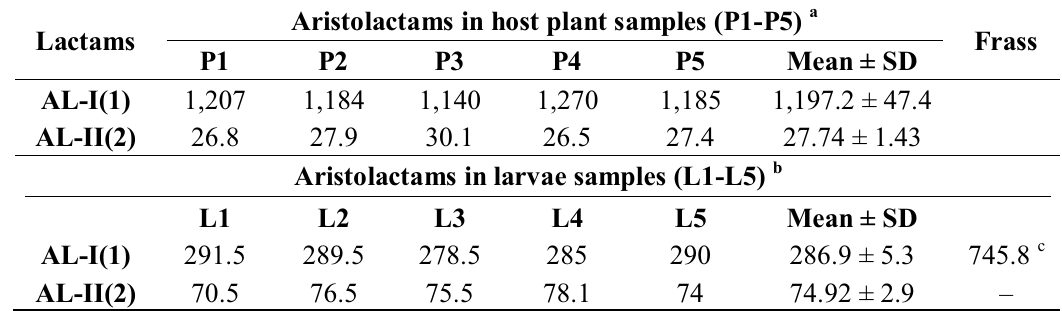
Table 2. Amount of aristolactams (in µg) in samples of the host plant Aristolochia chilensis and the fifth instar larvae of Battus polydamas archidamas and their frass.